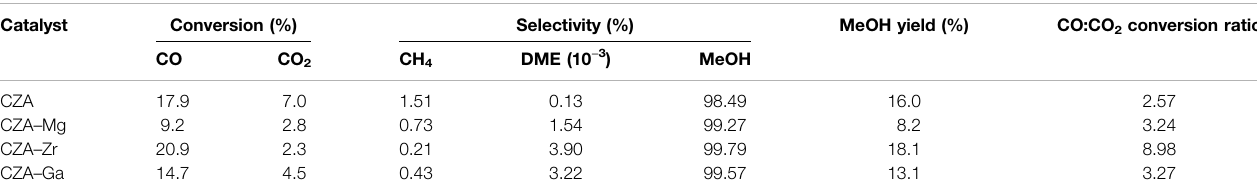
TABLE 2 | Comparison of methanol synthesis performance between CZA and promoted CZA.